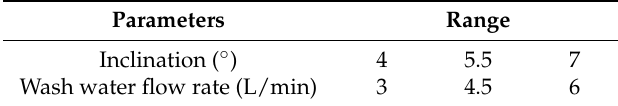
Table 2. Range of the parameters selected for the shaking table